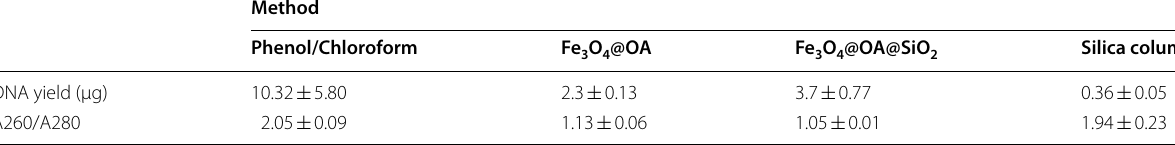
Table 2 Comparison of methods ro isolate DNA from whole blood